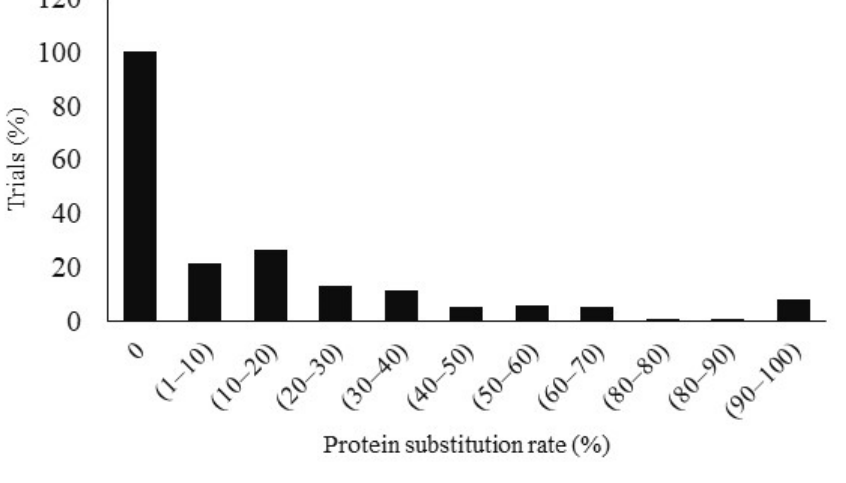
Figure 3. Protein substitution rate of fish meal by Black Soldier Fly meal according to trials.